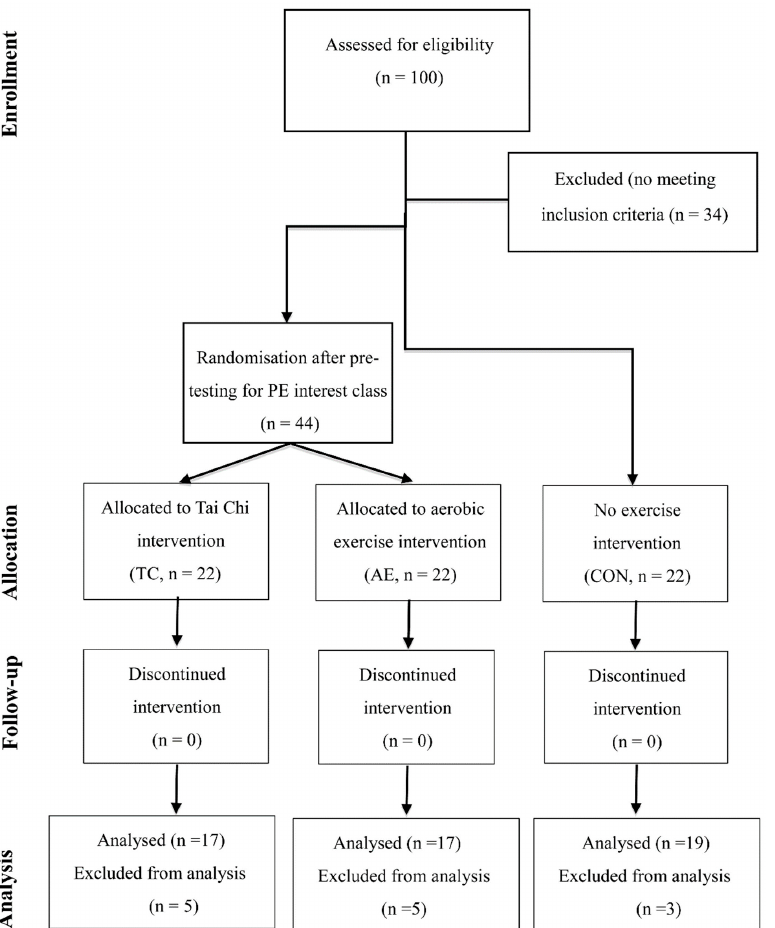
Figure 1. Flowchart shows study procedures including participant selection, outcome assessment, intervention protocol, and data analysis (PE = physical education, TC = Tai Chi, AE = aerobic exercise, CON = control group, PA = physical activity).